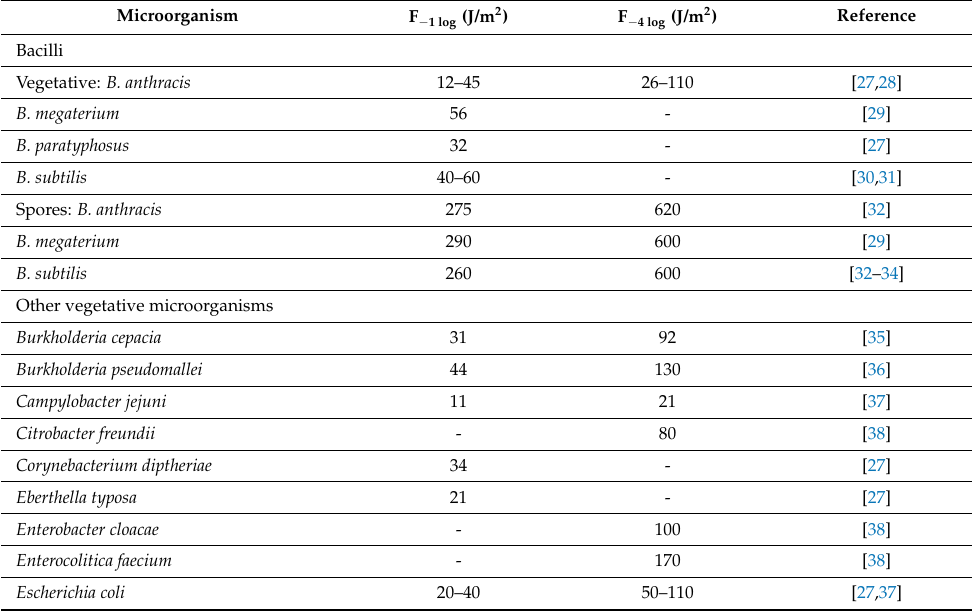
Table 1. UV-C lethal fluence (F) for varying levels of bacterial survival [14].